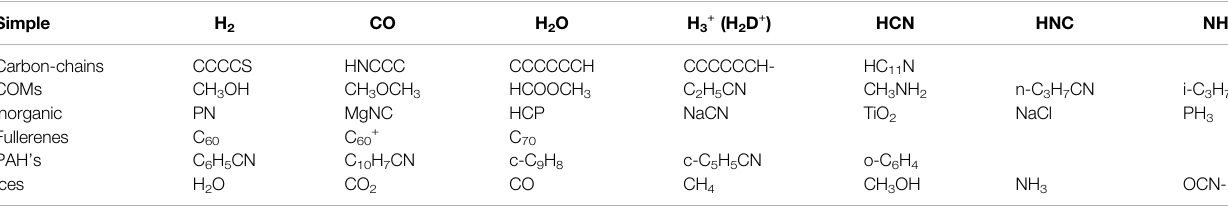
TABLE 1 | Classes of gaseous and icy interstellar molecules.